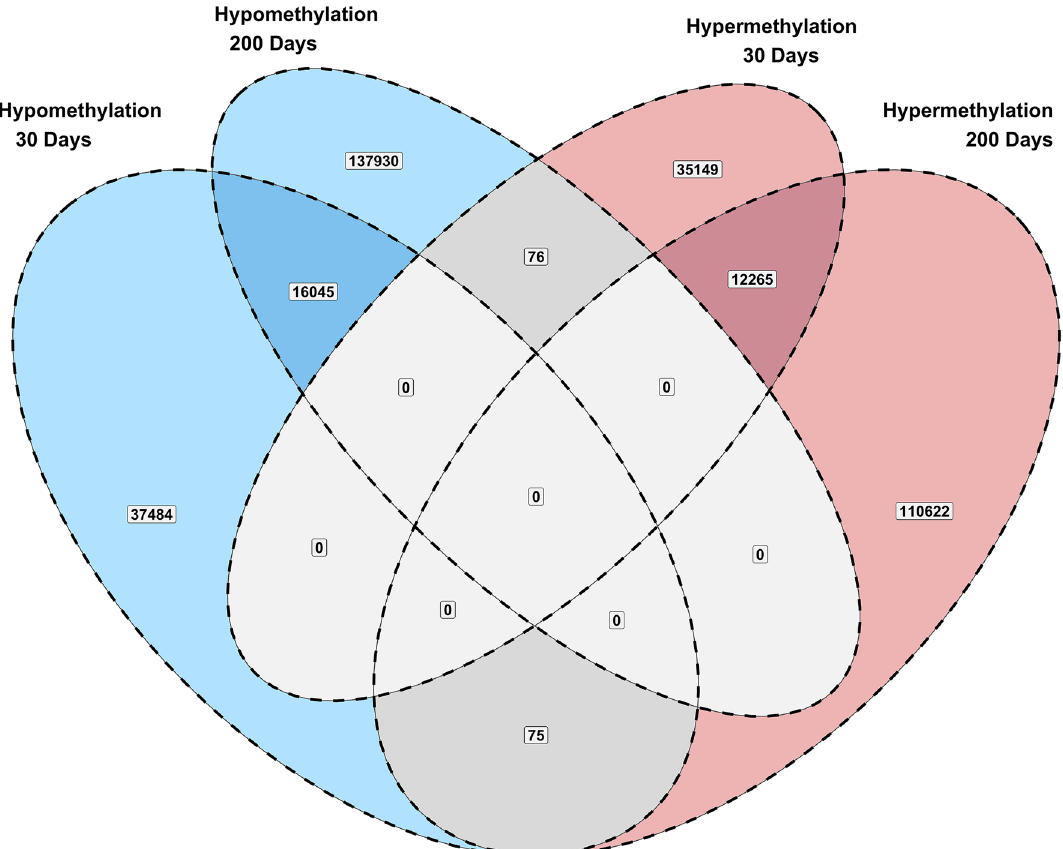
Figure 2. Summary of persistent DNA methylation changes over